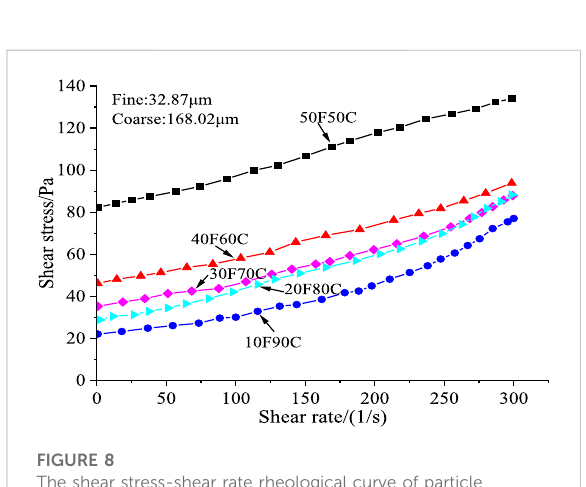
FIGURE 8 The shear stress-shear rate rheological curve of particle diameter 32.87 μ m.